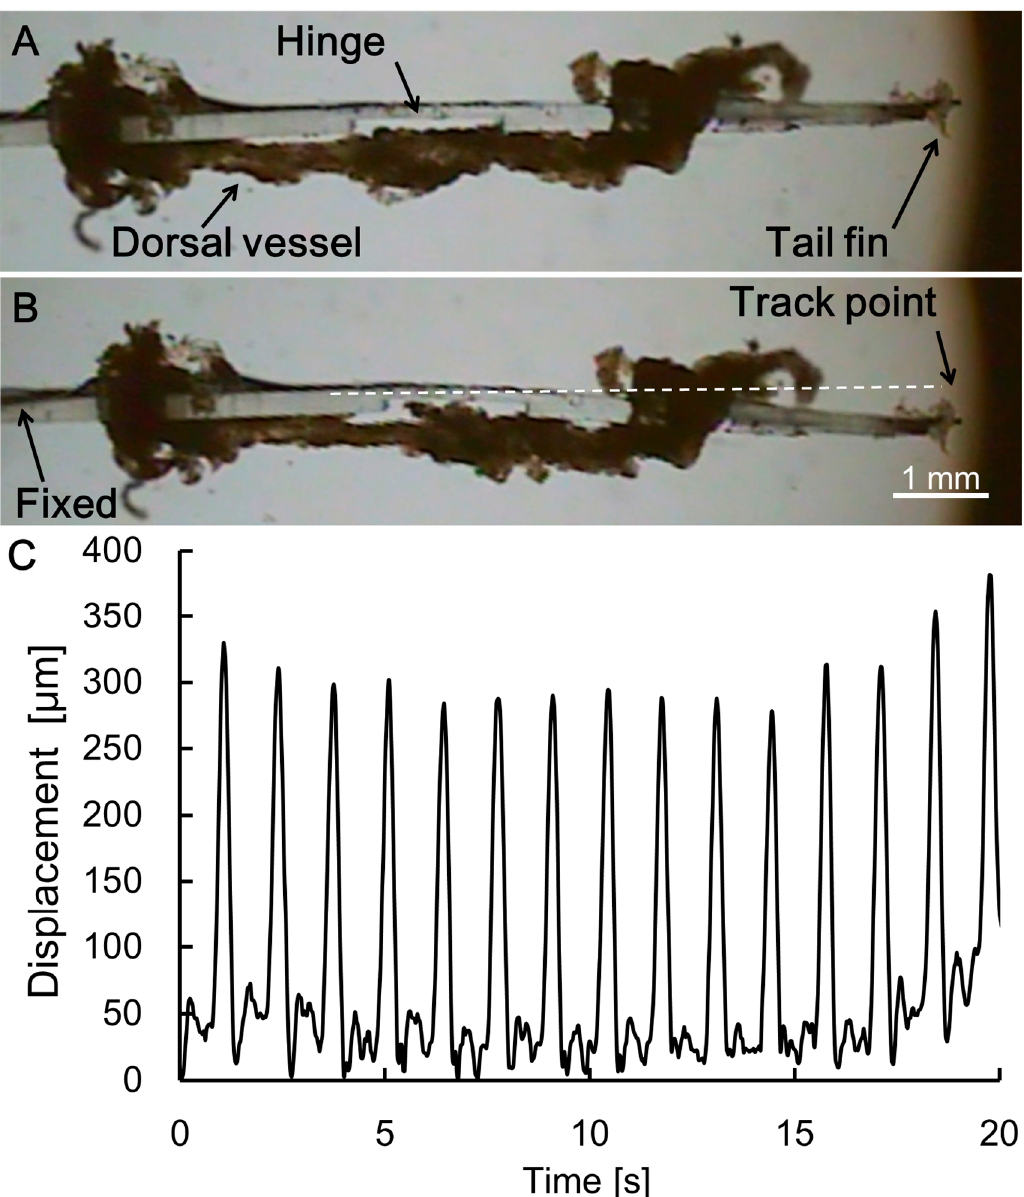
Figure 6. Motion analysis of the swimming robot tail fin. ( A ) Image of the swimming robot tail fin in a relaxed condition. The head of the robot was fixed and the motion of the track point was analyzed. ( B ) Image of the swimming robot tail fin in a contracting condition. The tail fin was slightly bent. The white scale bar is 1 mm. ( C ) Displacement of the tail fin of the swimming robot was plotted from the image